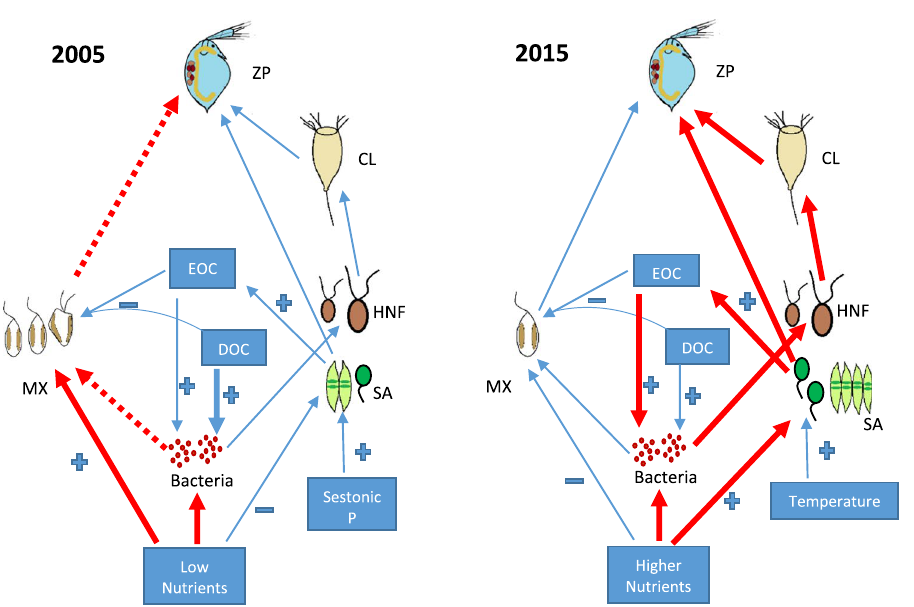
Figure 6. Scheme of the functional regulation of the trophic web in high mountain lakes in 2005 and 2015. Red and blue lines represent the type of interaction that is reinforced and diminished, respectively. Red dashed lines represent the C-bypass. ZP: zooplankton, CL: ciliates, HNF: heterotrophic nanoflagellates, SA: strict autotrophs, MX: mixotrophs, EOC: Excreted Organic Carbon, DOC: Dissolved Organic